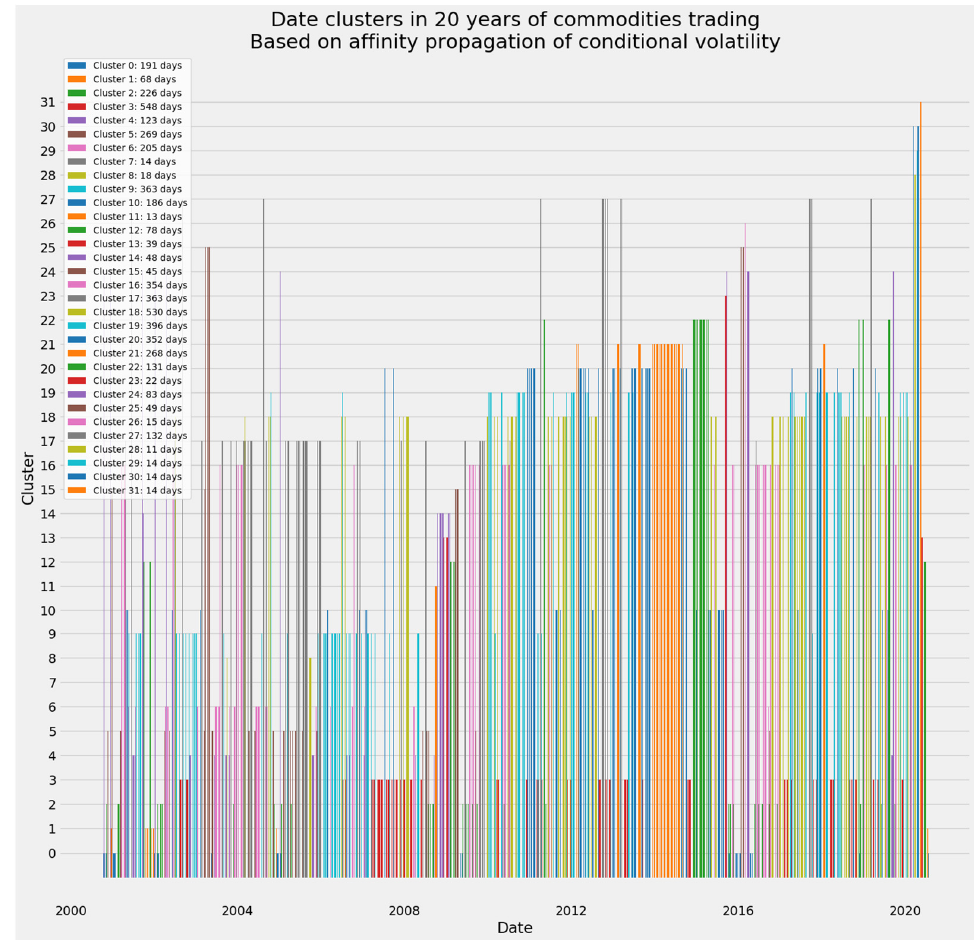
Figure 30. Affinity propagation of energy-related markets—An ordered timeline.